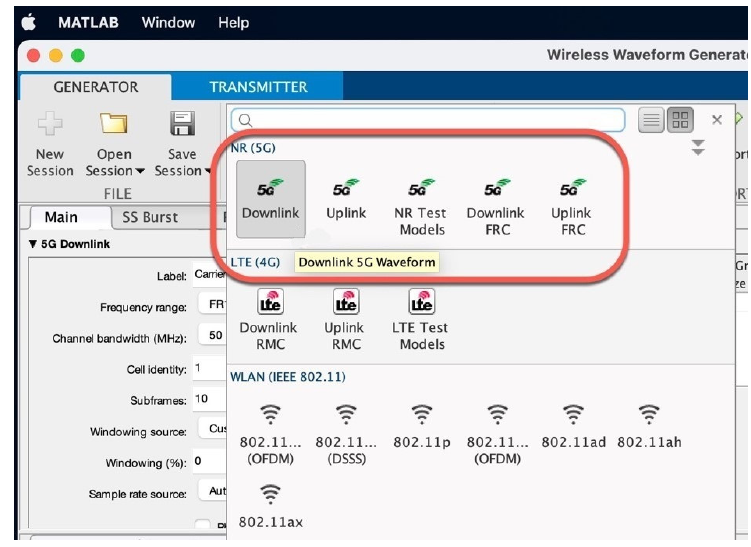
Figure 18. MATLAB provides various types of 5G signal simulations.